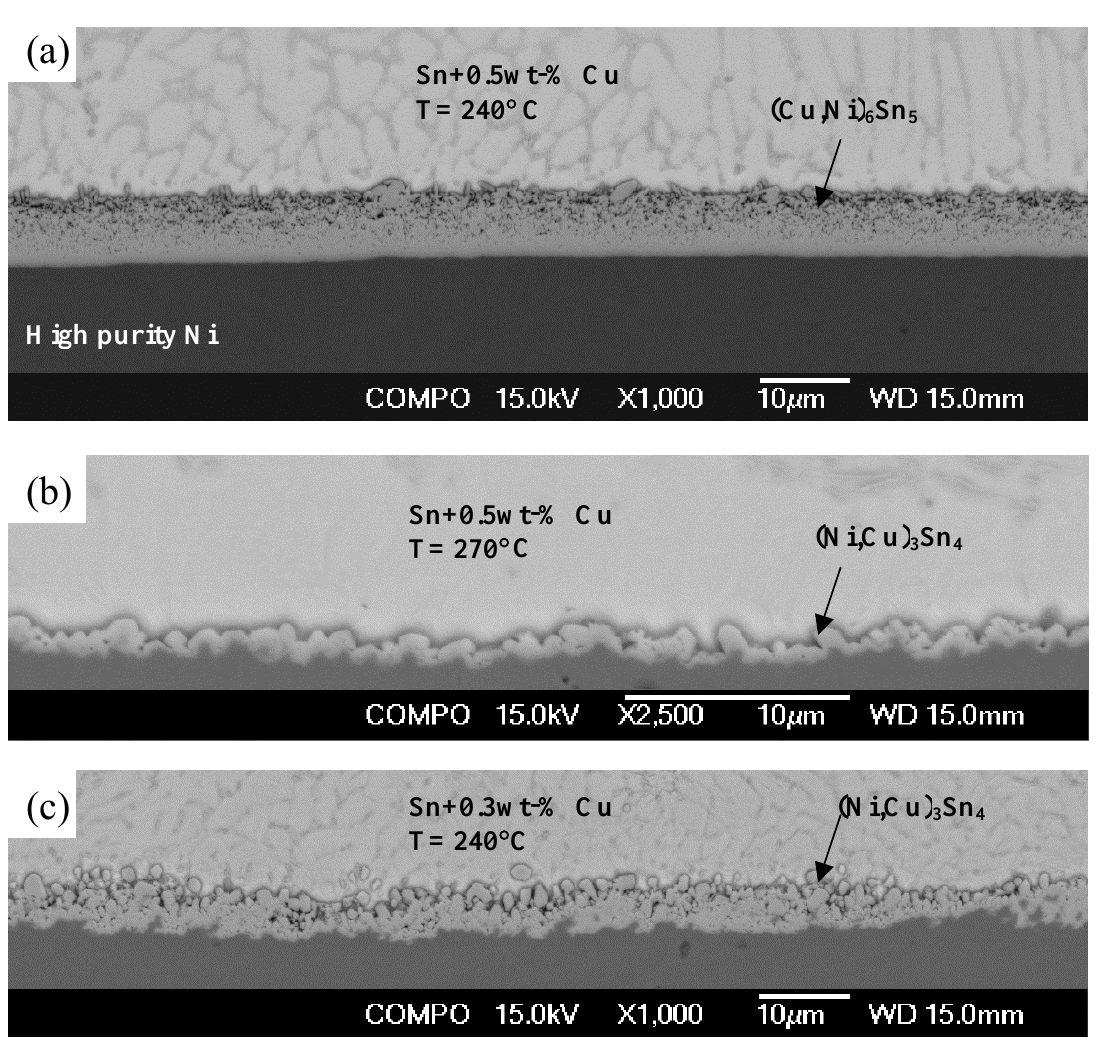
Figure 12. (a) Sn + 0.5wt-%Cu/Ni diffusion couple annealed at 240 °C, (b) Sn + 0.5wt-% Cu/Ni diffusion couple annealed at 270 °C, and (c) Sn+0.3wt-%Cu/Ni diffusion couple annealed at 240 °C for 60